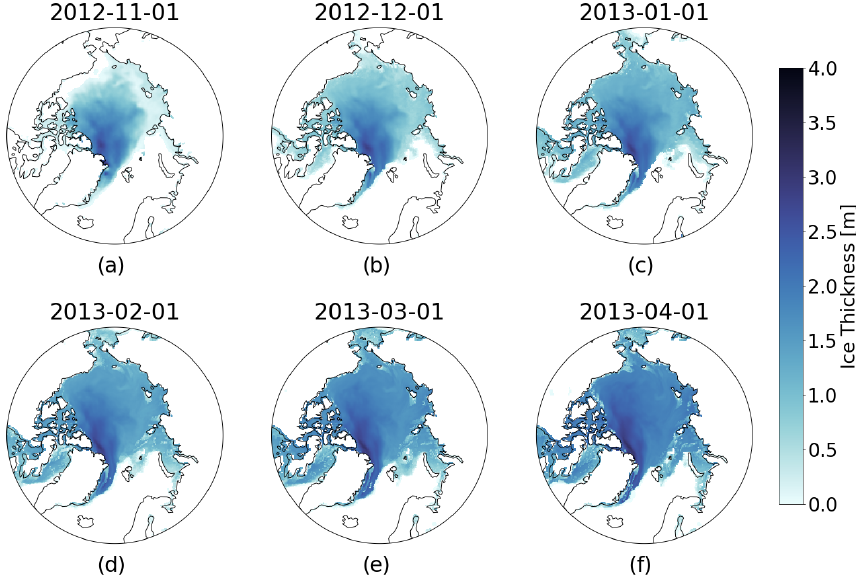
Figure 5. Sea ice thickness on (a) 1 November 2012, (b) 1 December 2012, (c) 1 January 2013, (d) 1 February 2012, (e) 1 March 2013, and (f) 1 April 2013 created using SLICE with the 1 November 2012 AWI CS2SMOS as an initial state. The changes from month to month represent thermodynamic growth and advection.